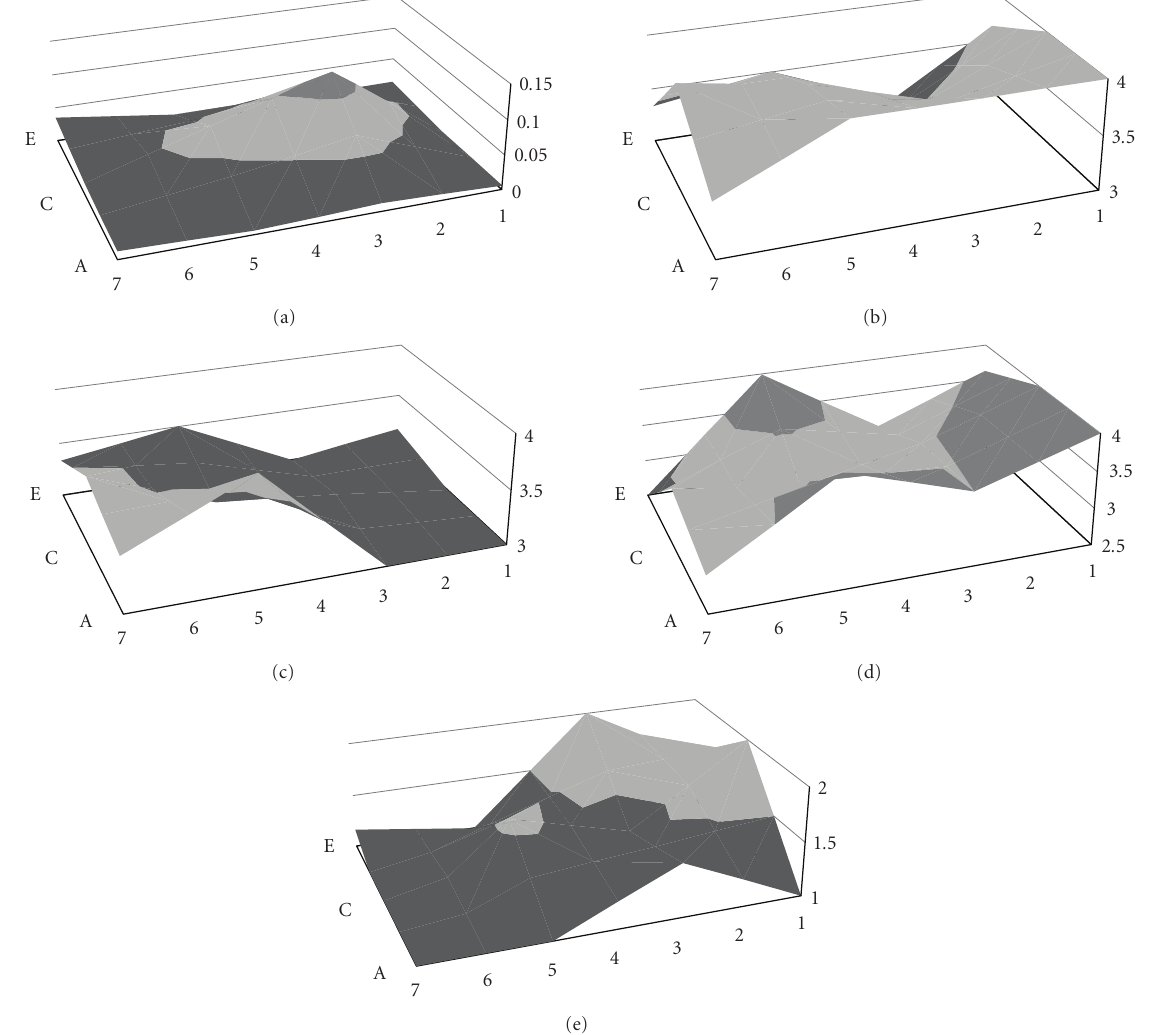
Figure 6: Subjective evaluation (5-degree level: from 0—“poor” to 4—“excellent”) of the result throughout the projection venue (A1 is located in front of the left part of the projection screen facing the audience): (a) samples distribution, (b) total experience, (c) video quality, (d) audio quality, and (e) perception of specific video